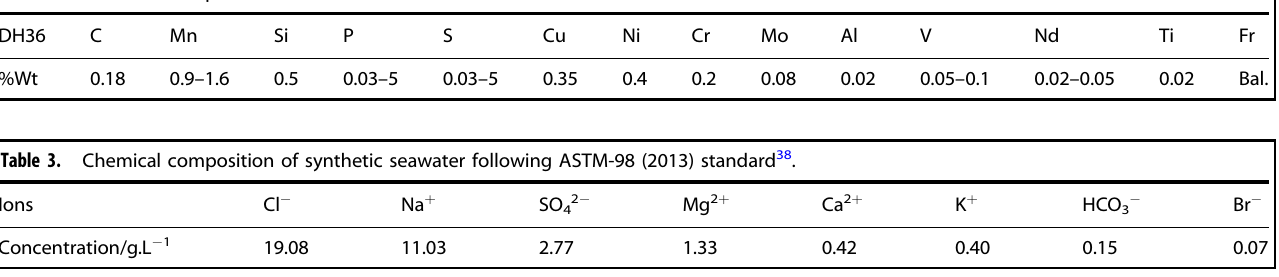
Table 2. Chemical composition of DH36 steel used as the hull material.